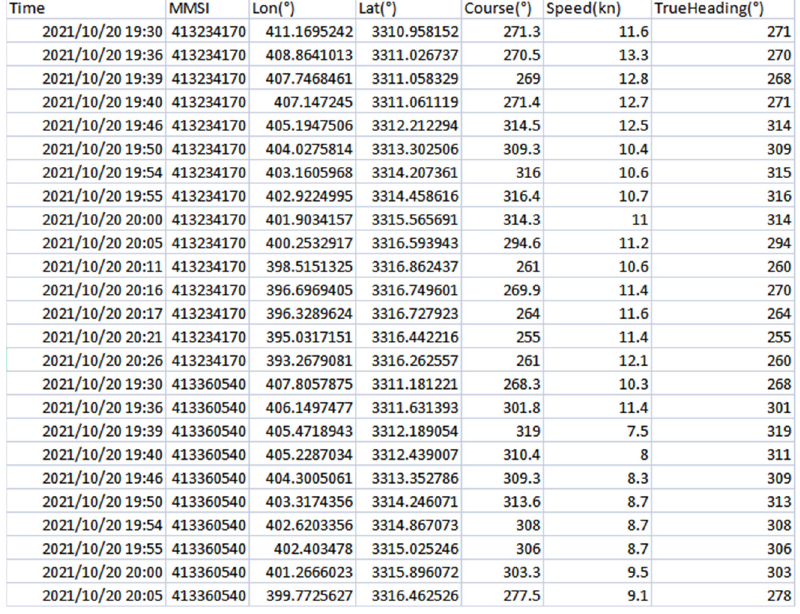
Figure 5. AIS data (partial).